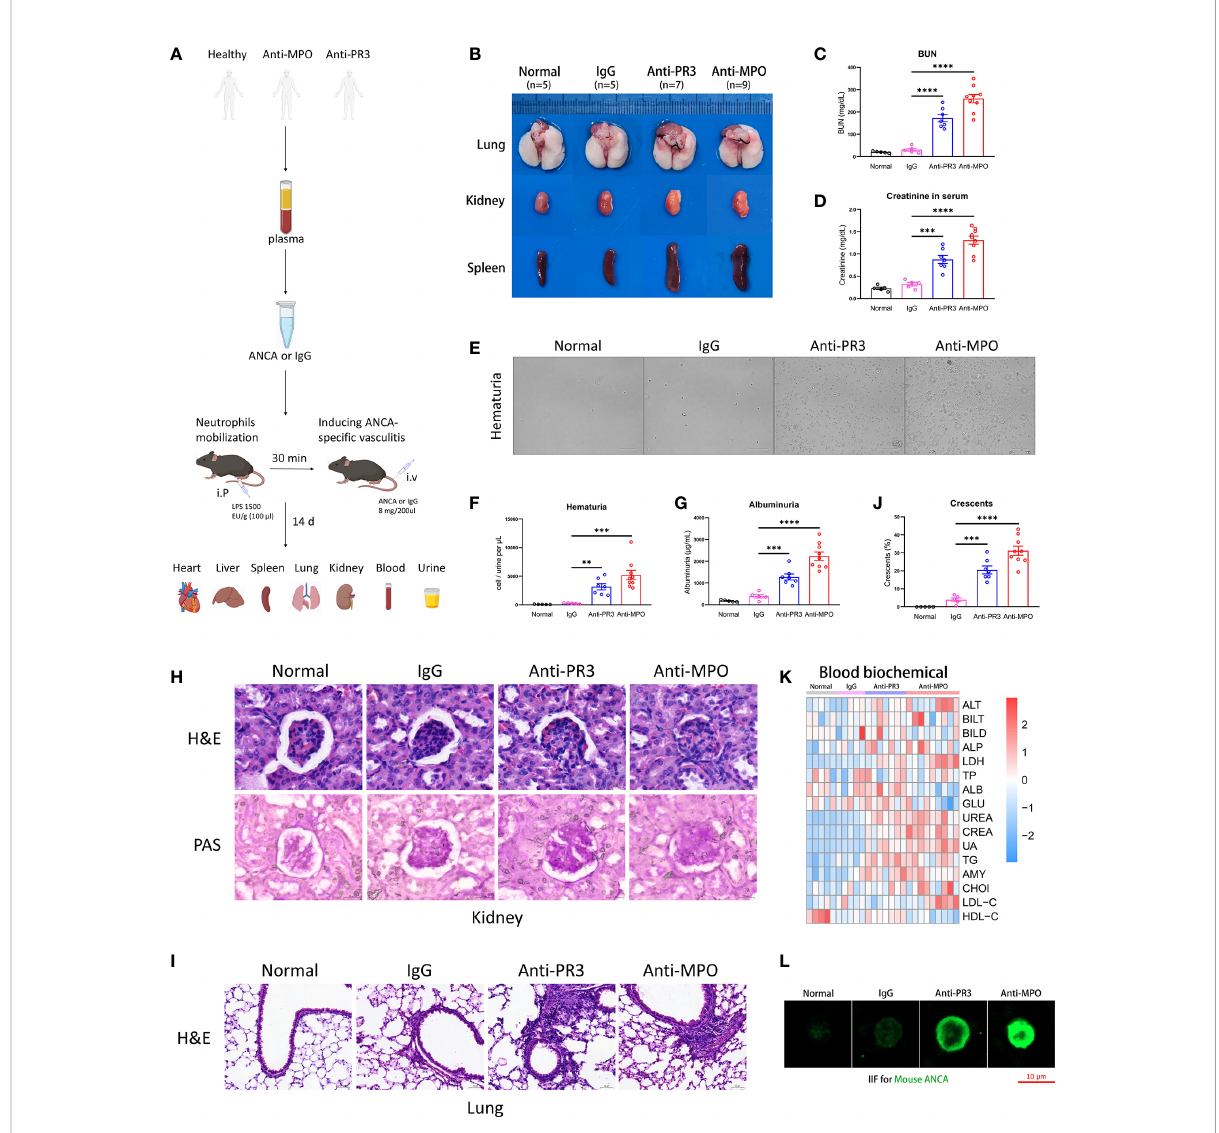
FIGURE 1 The ANCA-associated vasculitis model of mouse induced by human ANCA from patients. (A) The mouse model of ANCA-associated vasculitis, constructed with human IgG from healthy donors, anti-PR3 or anti-MPO vasculitis patients after neutrophil mobilization by LPS. (B) The representative pictures of the lung, kidney and spleen from all groups. (C, D) The comparison of urea nitrogen (C) and creatinine (D) in mouse serum. (E) The representative pictures of urine smear across all groups. (F, G) The comparison of hematuria (F) and albuminuria (G) . (H, I) H&E and PAS staining images of the kidney (H) and H&E staining images of the lung (I) from mice of all groups. Scale bar, 20 m m. (J) The summarized number of crescents among all groups. (K) The detection of biochemical indexes in mouse serum. (L) The